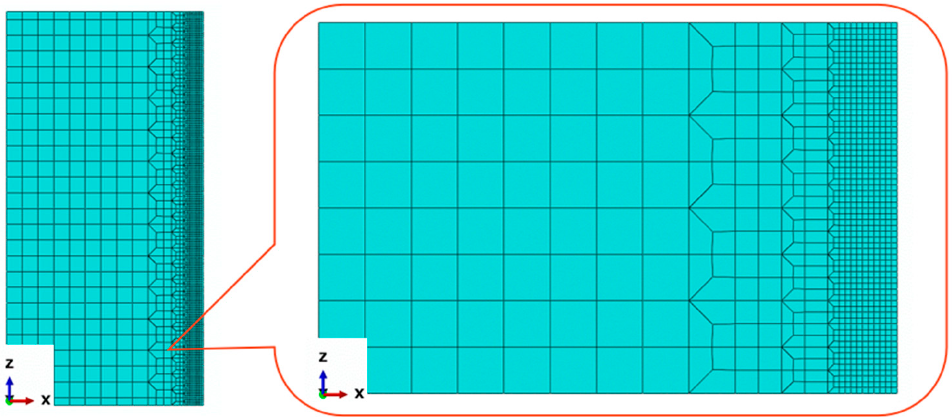
Figure 6. Meshing of the finite element model.